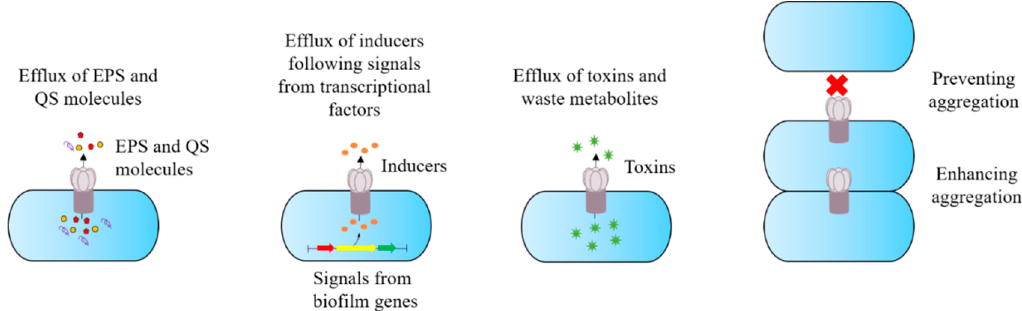
Figure 3. Schematic diagram of the potential role of efflux pumps in biofilm formation, as demonstrated through numerous studies. Adapted from Alav et al. [35] . EPS: extracellular polymeric substance; QS: quorum signals.